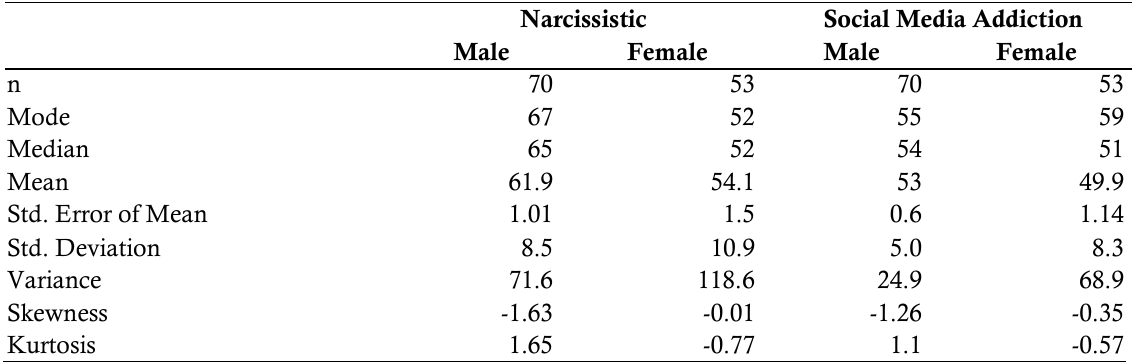
Table 5 . Narcissistic Descriptive Test Results and Social Media Addiction Based on Gender